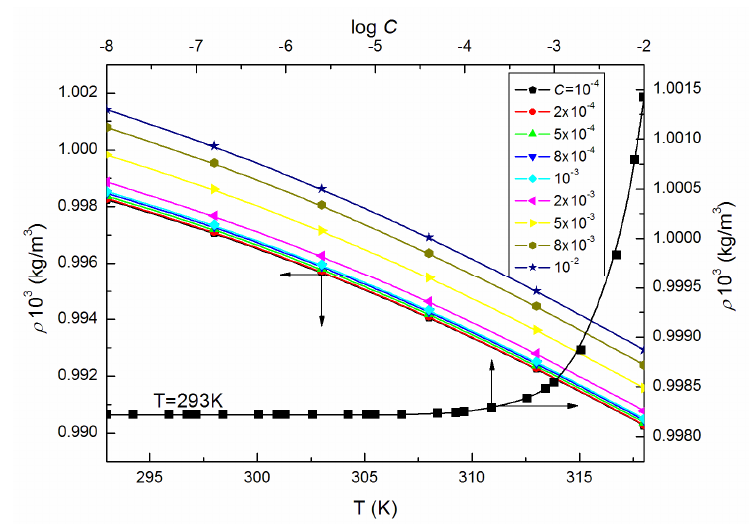
Figure 9. A plot of the values of ρ of the aqueous solutions of ELP at C from 10 − 4 to 10 − 2 M vs. the temperature, T, as well as the values of ρ of the aqueous solutions of ELP at T = 293 K vs. log C .